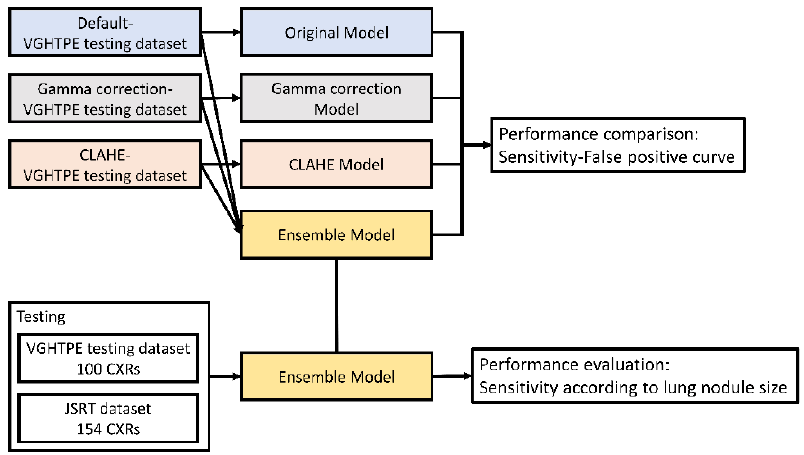
Figure 6. Performance evaluation of the different lung nodule detection models.